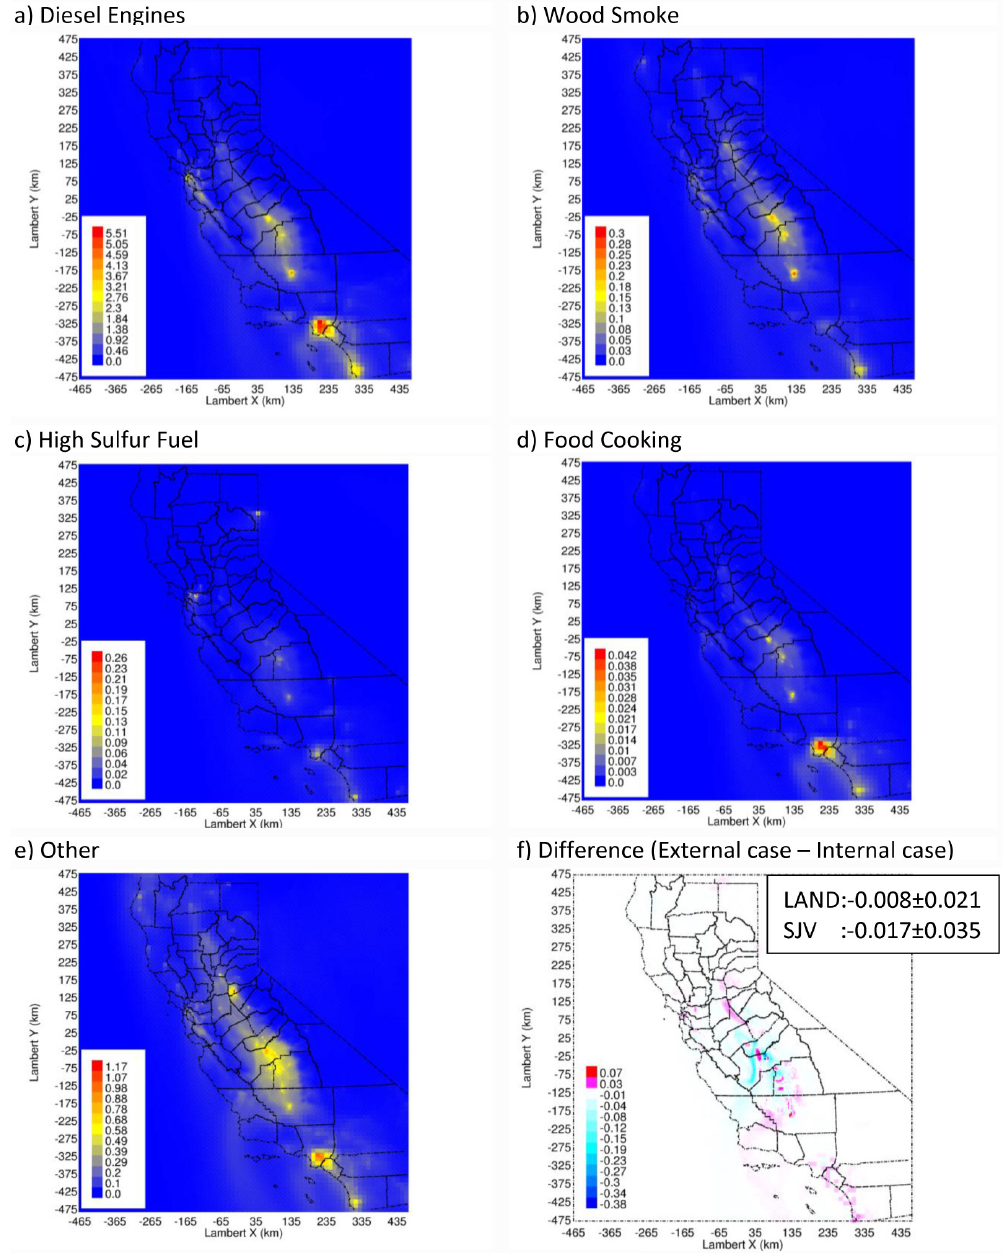
Fig. 8. 24h averaged elemental carbon concentrations associated with primary particles emitted from different sources predicted by the external case (a–e) on 24 December 2000, and difference between external case and internal case (f) . Units are µgm − 3 . Note that the maximum value for each panel is adjusted to best illustrate the spatial patterns. Averaged differences over land and the SJV covered by the 4km domain are shown in the text